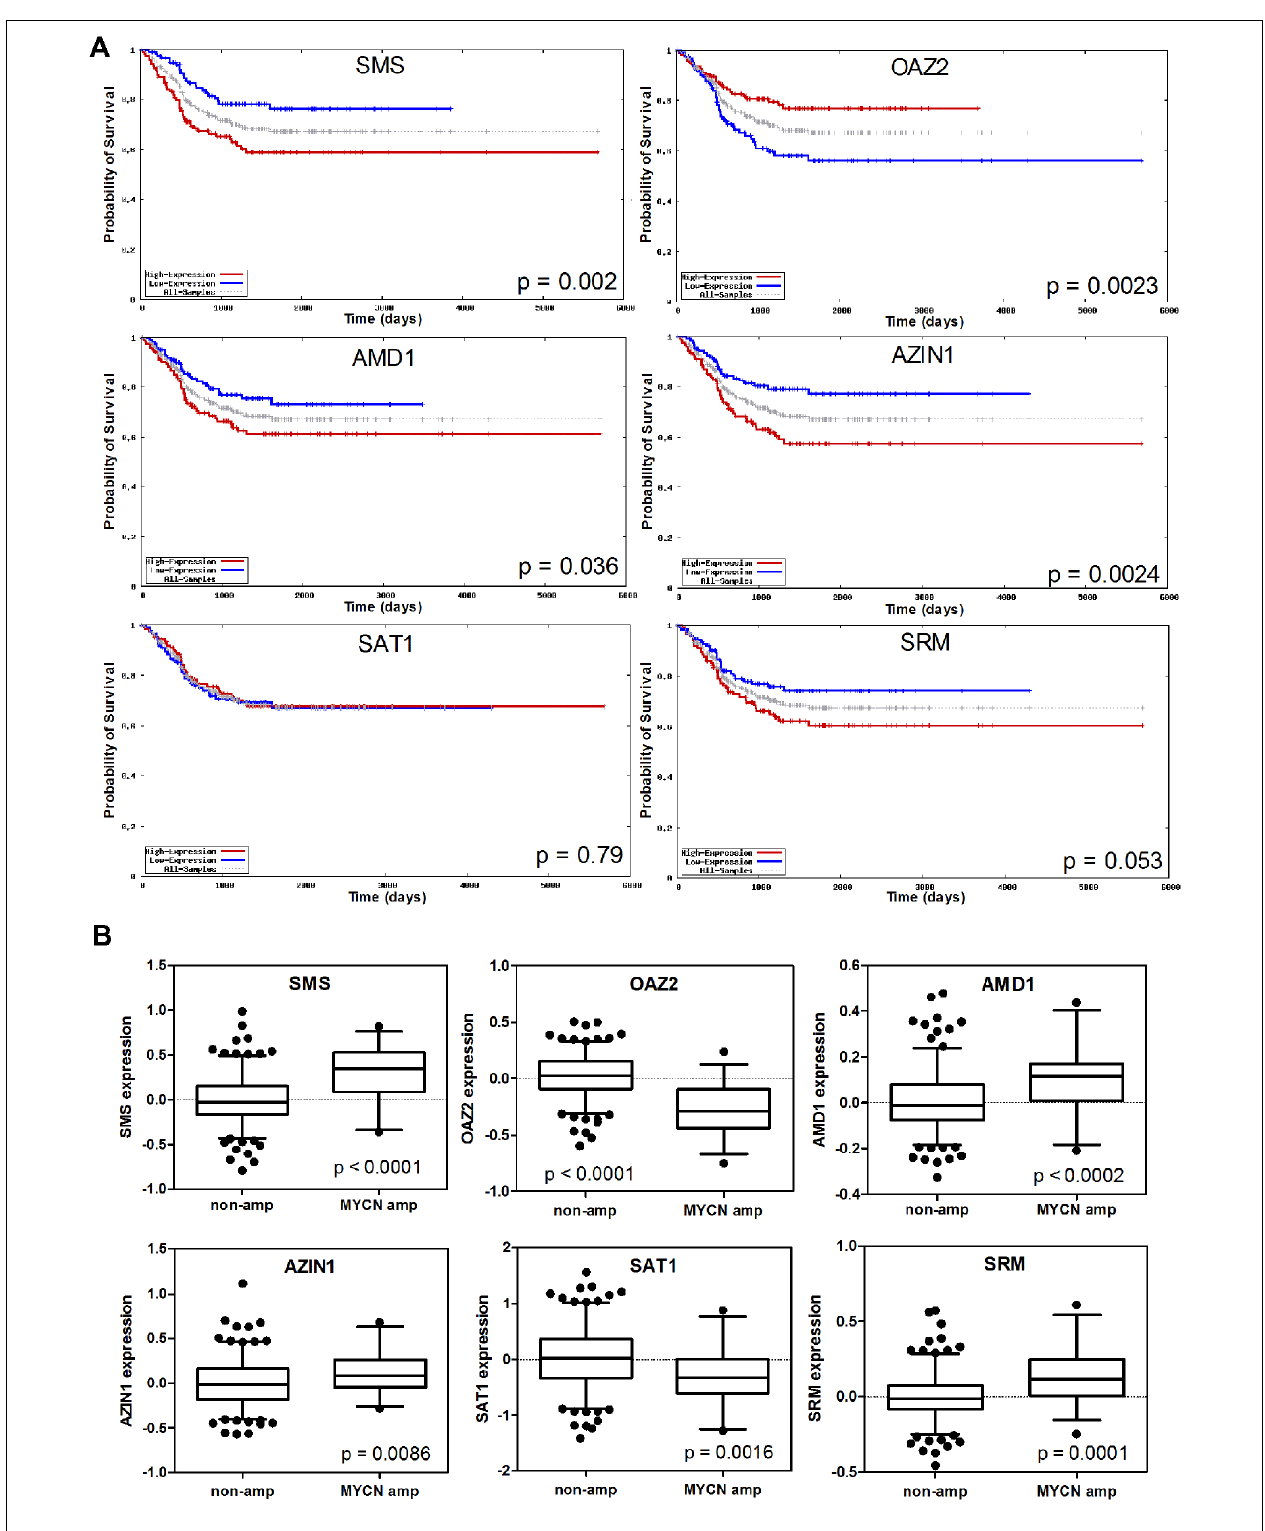
the median. (B) Expression of polyamine pathway genes in the subsets of tumors with and without MYCN amplification. Data was obtained from the Neuroblastoma Prognosis Database (publically available at http://home.ccr.cancer.gov/oncology/oncogenomics/).